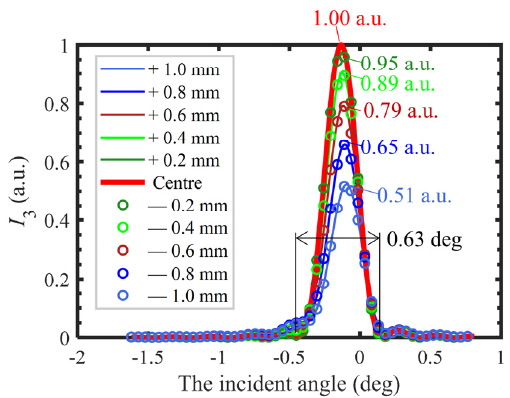
Figure 10. The figure for showing the effect of different focused positions on angle dependence. The lines/circles in different colors correspond to the positive/negative beam waist movements relative to the crystal center.